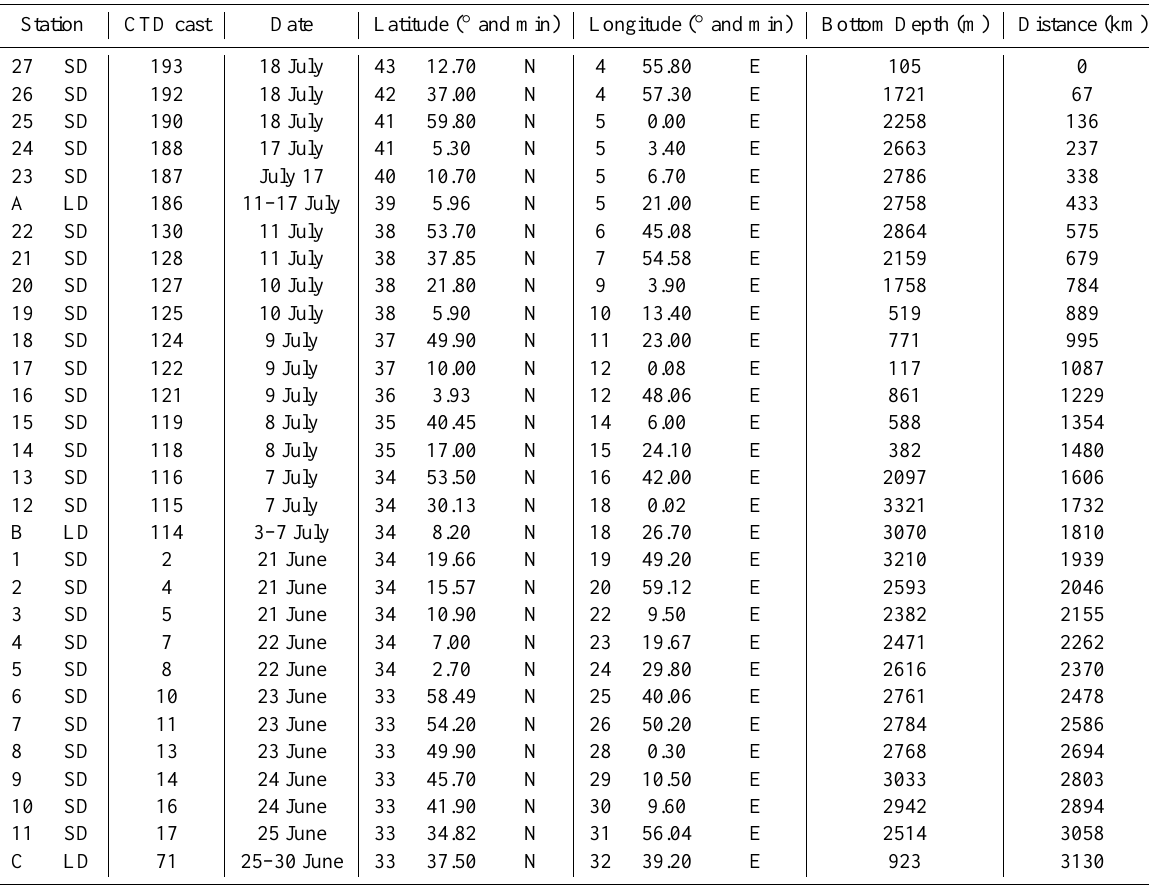
Table 1. Date, location and general characteristics of the stations investigated along the BOUM transect. Distance (km): distance from the Rhˆone river mouth (SD27).